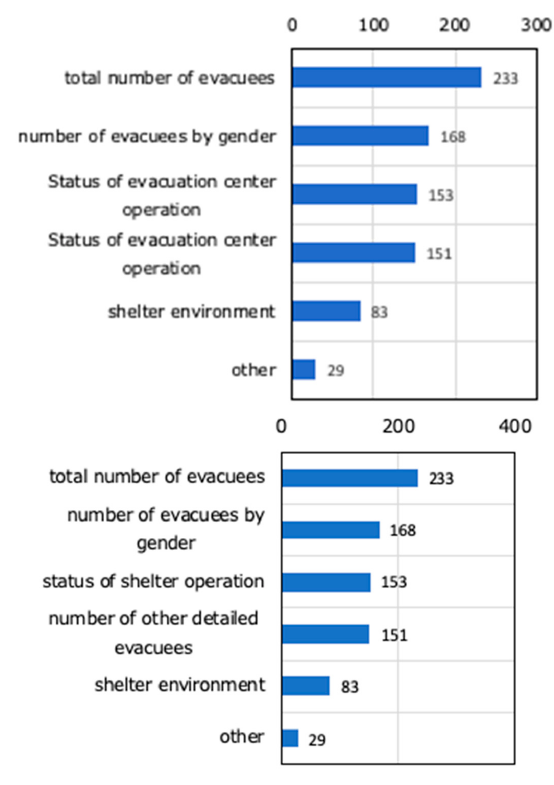
Figure 15. Contents of information sharing with the disaster response headquarters (multiple answers) (Multiple answers, total number of responses 814, total number of respondents: 203, unit: number of responses).